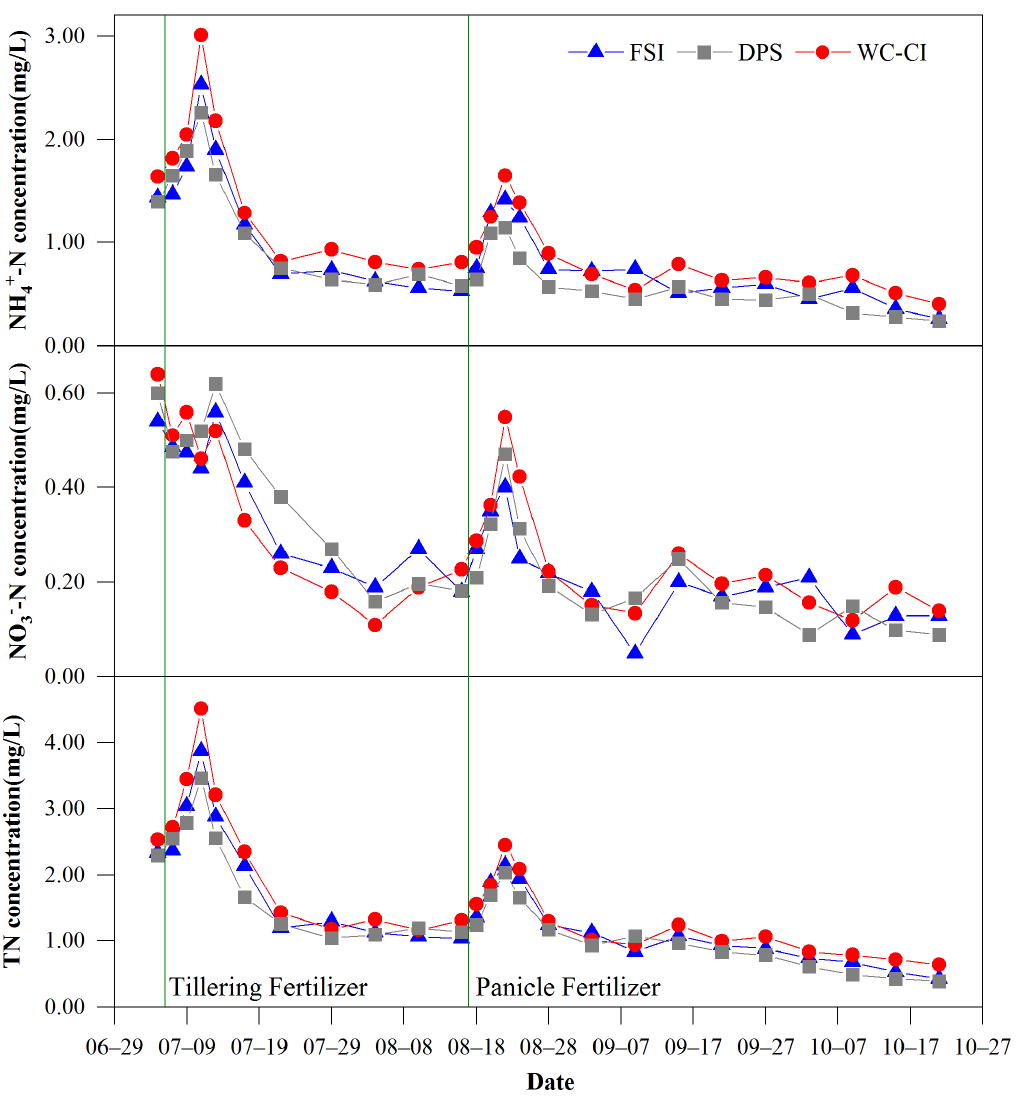
Figure 4. Variation of NH 4+ -N, NO 3 − -N and TN concentrations in deep percolation water under different irrigation and drainage modes. The two green lines in the Figure 4 represent the time of tillering fertilizer and panicle fertilizer.